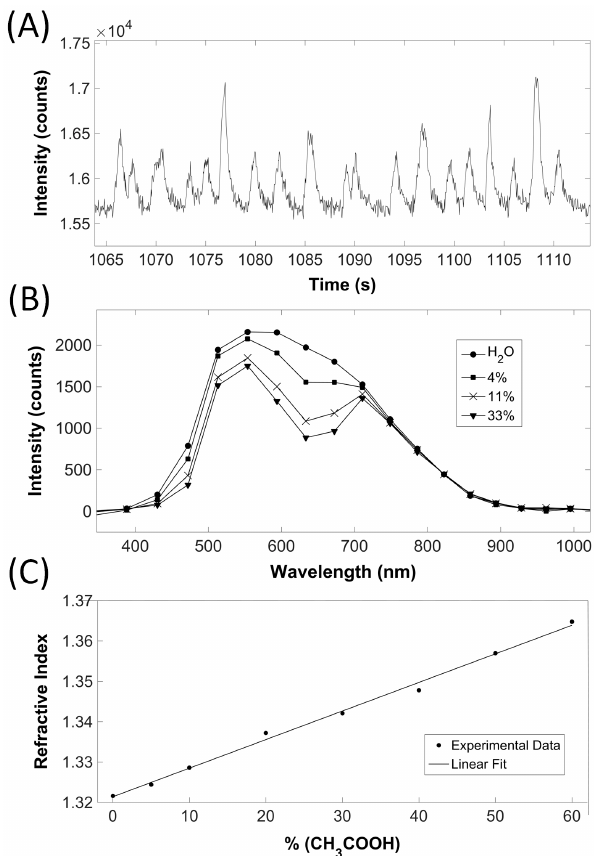
Figure 5. Optical characterization results obtained by the developed platform (see Figure 1E for the setup diagram): ( A ) counting of fluorescence beads (intensity corresponds to the sum of the detected charged-coupled device (CCD) counts over a 5-nm interval around the spectral emission peak at 582 nm); ( B ) absorption spectra of various malachite green-dyed solutions (each spectra corresponds to approximately 4000 data points with an associated uncertainty of ±2 counts); and ( C ) refractive index variation as a function of acetic acid concentration (each data point has an associated maximum uncertainty of 10 − 4 refractive index units).